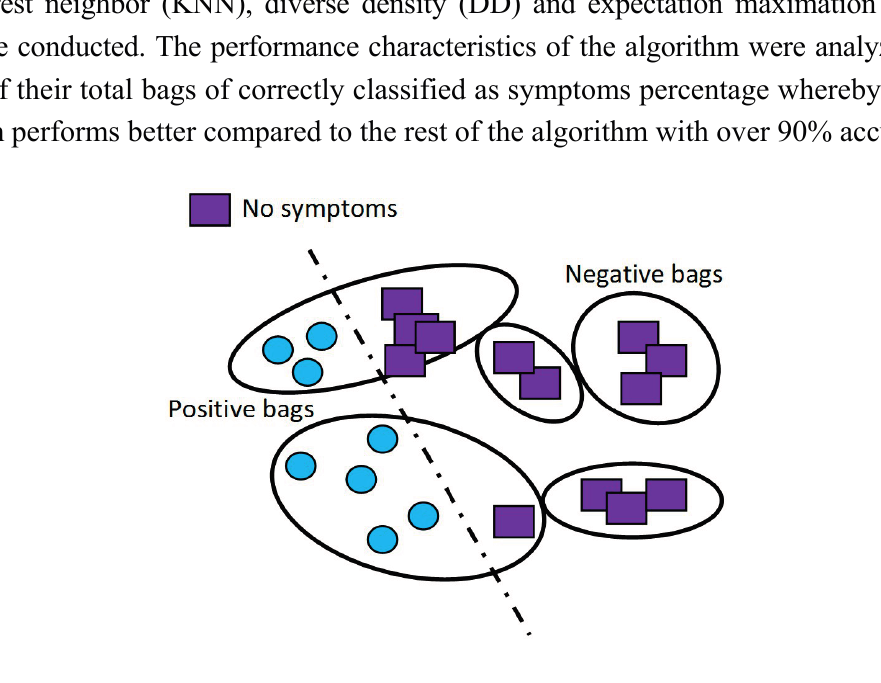
Figure 9. The intuitive idea behind multiple instances learning (MIL) (adapted from